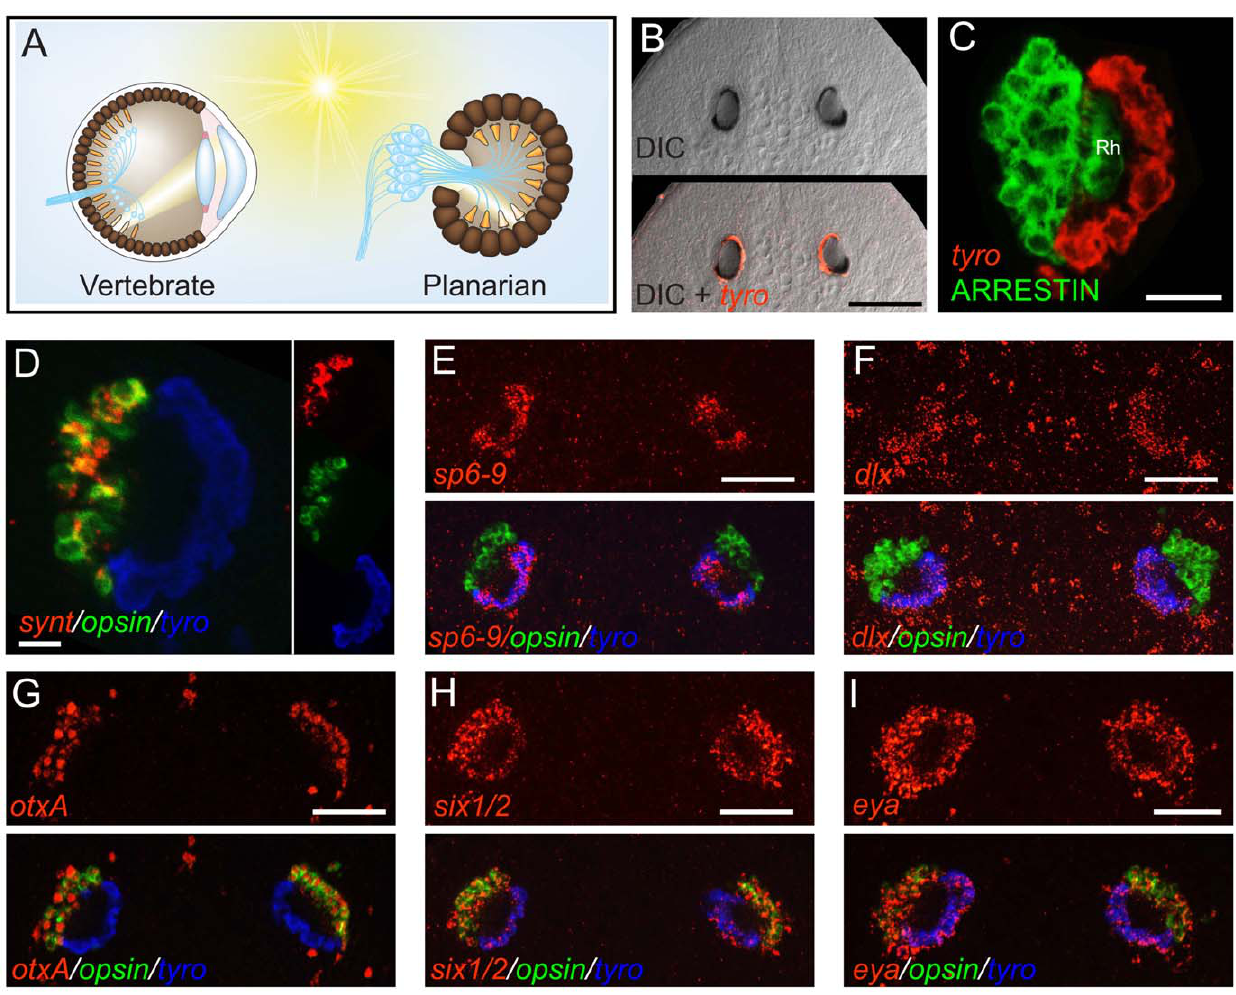
Figure 1. The planarian optic pigment cup expresses dlx and sp6-9 . Anterior is up in all images, and all eyes are shown at day 6 of regeneration except in (B). Fluorescent images are fluorescent in situ hybridizations (FISH) unless otherwise noted. (A) Schematic highlighting similarities between the vertebrate (left) and planarian (right) optic cup. Light-sensing organelles (orange), neuronal cell bodies and processes (blue), and pigmented cells of the optic cup (brown) are depicted. Neural circuitry of the vertebrate retina is highly simplified. (B) Smed - tyrosinase ( tyro ) is expressed in the optic (pigment) cup of an intact planarian. (C) Planarian photoreceptor neurons, labeled by an anti-ARRESTIN antibody [60] are adjacent to the pigment cup and extend rhabdomeres (Rh) into the cup lumen. (D) The optic cup does not express opsin or synaptotagmin (synt) . (E–I) Expression of transcription factors in the planarian eye during head regeneration. sp6-9 (E) and dlx (F) are expressed in the optic cup. (G) otxA is expressed in the photoreceptor neurons, similar to the case for D. japonica [20]. six1/2 (H) and eya (I) are expressed in both the optic cup and photoreceptor neurons, similar to the case for other planarian species [3–4]. Scale bars, 100 m m (B, D), 50 m m (C, E–I).